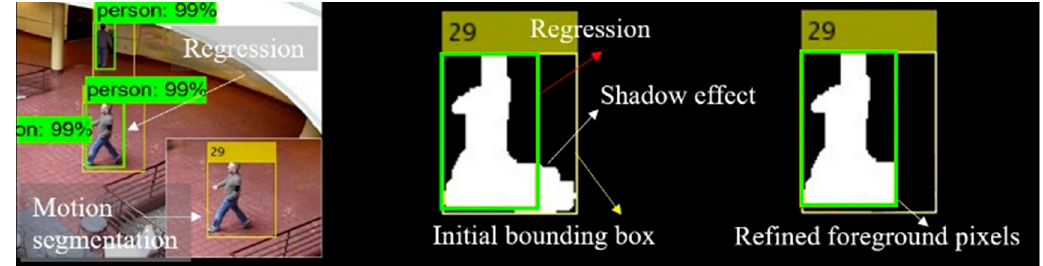
Figure 4. The foreground object pixels polished by the regressive bounding box.